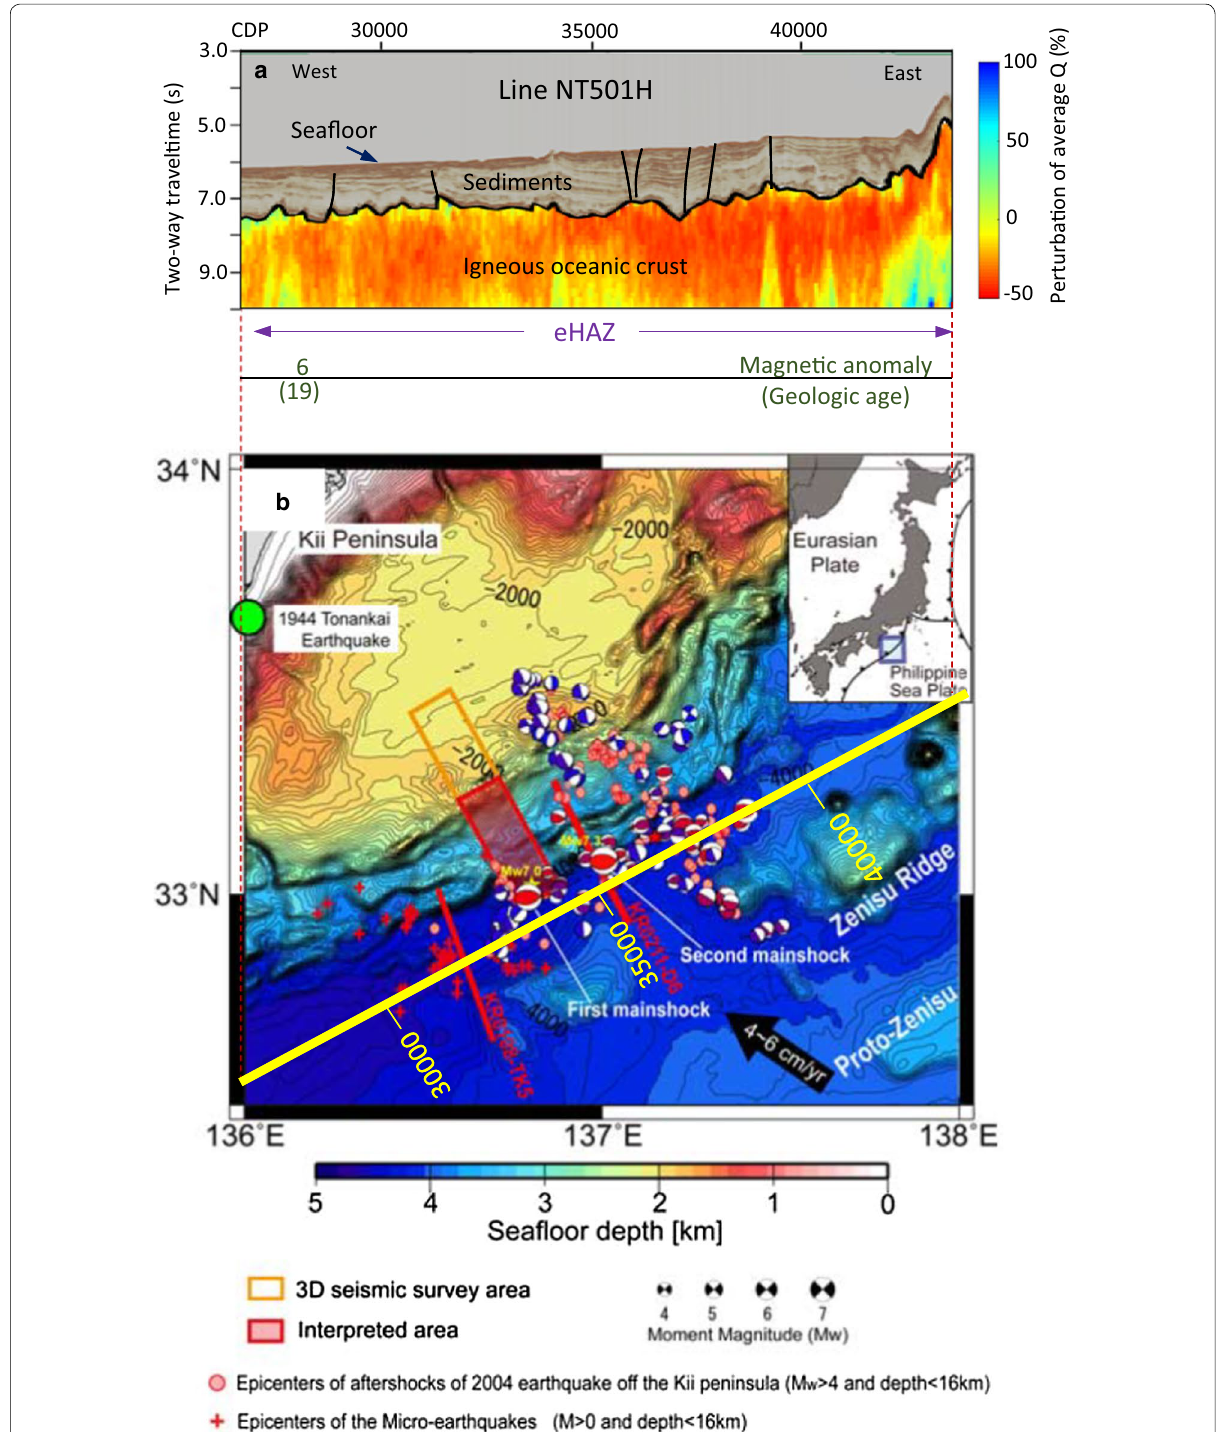
Fig. 13 Intraplate earthquakes in the incoming oceanic crust off Kii Peninsula based on Tsuji et al. (2009). Yellow solid line represents NT501H. The focal mechanisms of mainshocks and aftershocks of the 2004 off the Kii Peninsula earthquake by Ito et al. (2005) are shown on the bathymetry map. The epicenters of the aftershocks determined from a dense array of ocean‑bottom seismometers (Sakai et al. 2005) and the epicenters of micro‑ earthquakes during the inter‑seismic period (Obana et al. 2005) are mapped with red circles and red crosses, respectively. The active seismicity can be seen on the extremely high‑attenuation zone (eHAZ). The orange rectangle shows the previous 3D seismic survey area. The red‑shaded area within the orange rectangle and red solid lines are 3D interpreted area and 2D interpreted seismic lines by Tsuji et al. (2009),